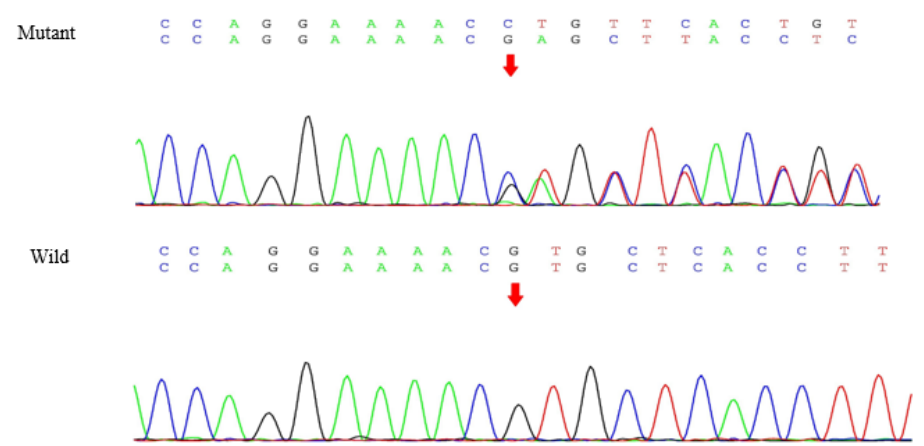
Figure 4. Sanger sequencing identified the mutation in SLC12A3.